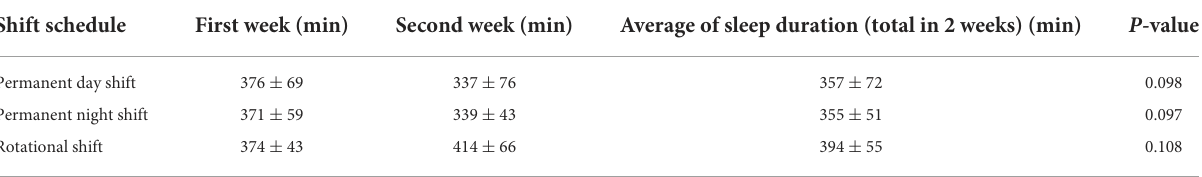
TABLE 4 TST values for various shift arrangements in the first 2 weeks of the study.